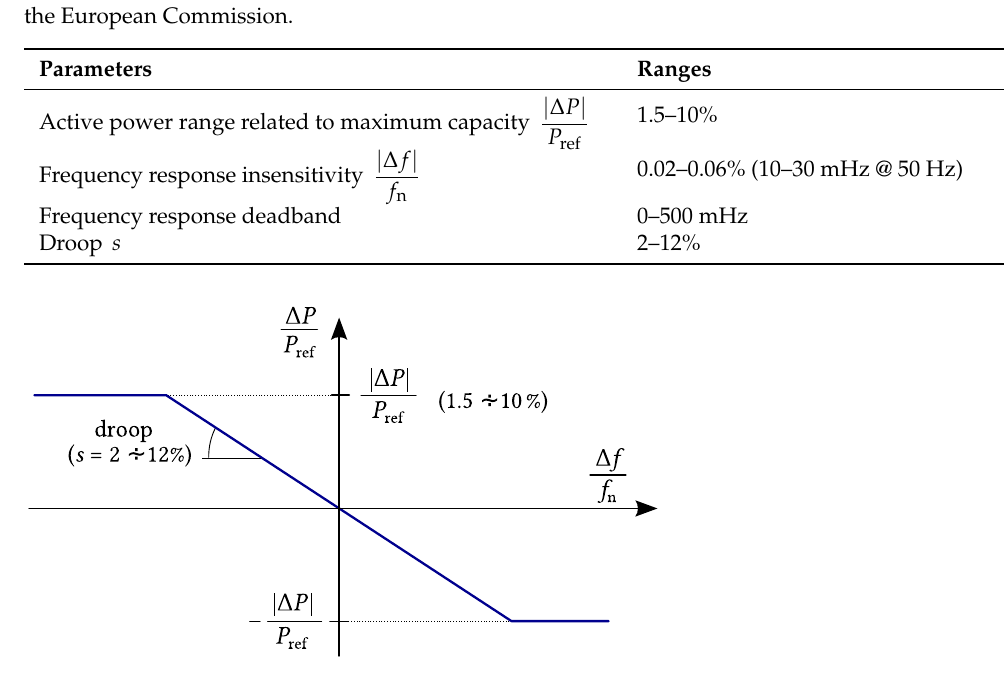
Figure 6. Active power frequency response capability of power-generation modules in Frequency Sensitive Mode illustrating the case of zero deadband and